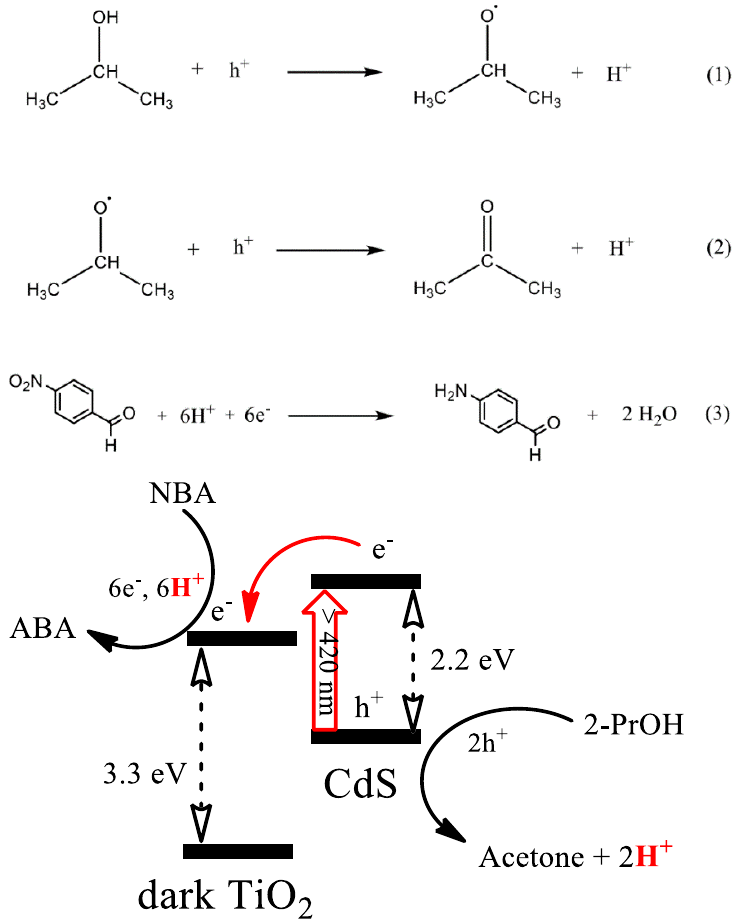
Scheme 1. Proposed photocatalytic